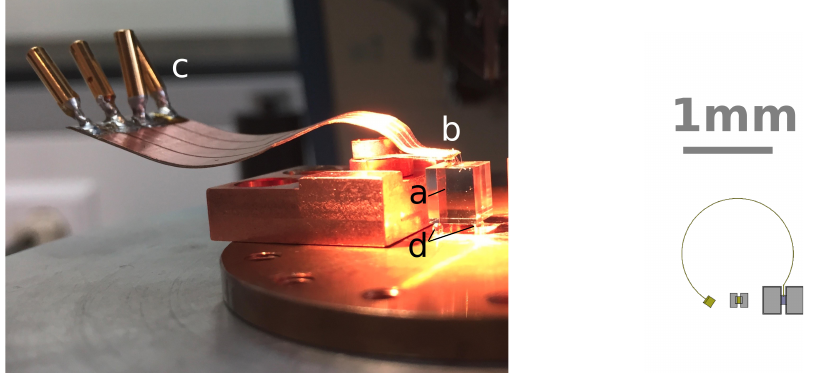
Figure 7: Left: NUCLEUS 1g-prototype setup: a) Al b) clamp holding the detector via a 1 mm Al bondpad for electrical and thermal connections; c) contacts for heater and bias lines; d) 3 Al O spheres glued on a copper plate to support the target from below. Right: 2 3 TES sensor layout used on the Nucleus 1g-prototype. Aluminum layers are shown in grey, tungsten in blue, gold layers in yellow. Left to right: thermal link bond pad, ohmic heater, TES sensor. Figures from Ref. [ 47 ]